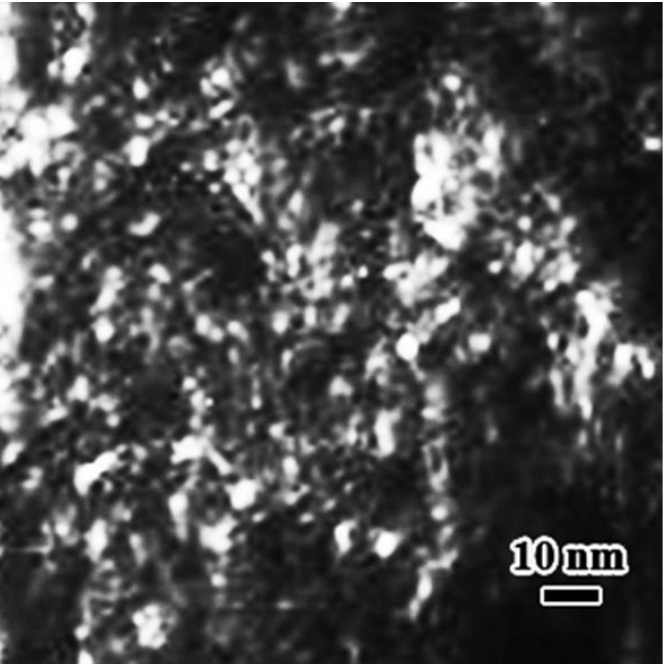
Figure 6. An enlarged image of a local region in Figure 5d. Several regions with a large particle size are visible. This is due to the aggregated nanocrystals in the regions having a much closer crystal orientation. It is difficult to separate them at the same contrast level. When the brightness in the regions was reduced, finer grains could be seen clearly.